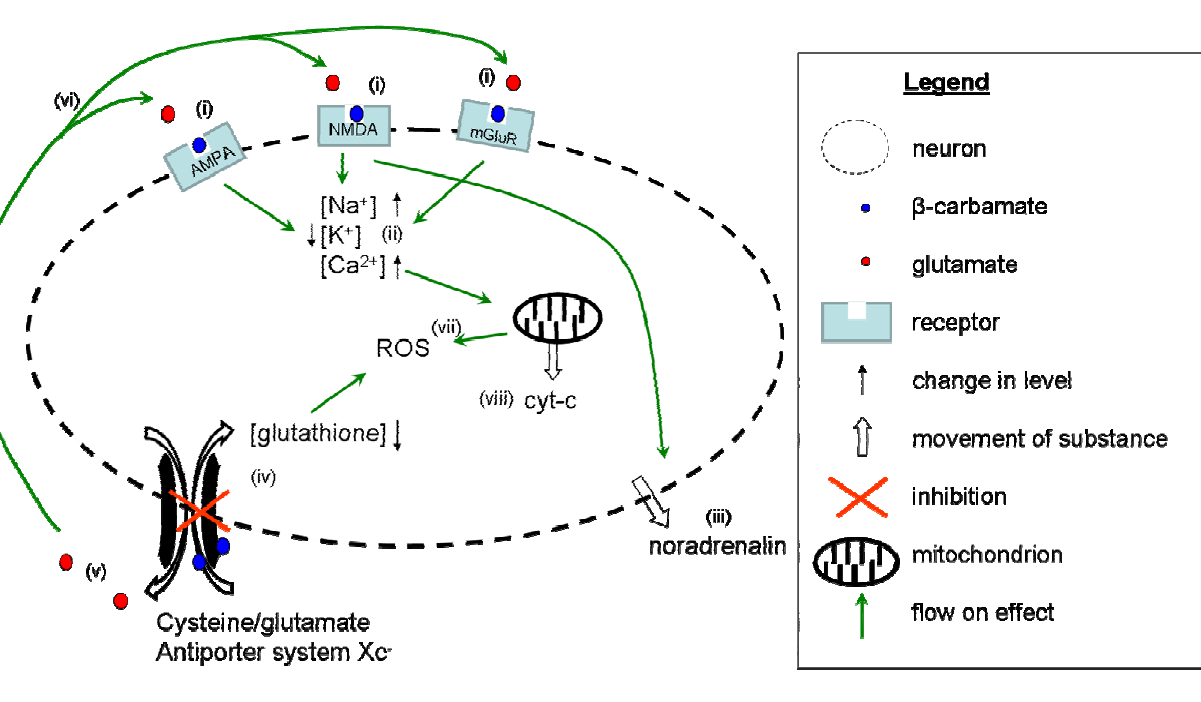
Figure 3. Illustrative summary of the modes of action of BMAA on neurons. In vivo , BMAA is present as a β -carbamate (represented by the blue dots), which binds to NMDA, AMPA and mGlu receptors ( i ). Activation of glutamate receptors results in an increase in the levels of Na + and Ca 2+ in the cell, accompanied by a reduction in K + ( ii ). The cell becomes depolarised and the membrane becomes permeable, as illustrated by the dotted line, and combined with NMDA receptor activity, noradrenalin is released from the cell as a result ( iii ). The cysteine/glutamate antiporter system Xc − is inhibited, as indicated by the red X ( iv ), leading to intracellular depletion of glutathione and an increase in ROS. This inhibition also causes an increase in the release of glutamate ( v ), which then binds to receptors to induce further excitotoxicity ( vi ). All these mechanisms combine to cause an increase in the generation of ROS ( vii ). The elevation of Ca 2+ leads to overload of the mitochondria resulting in a massive release of cyt-c into the cytosol ( viii